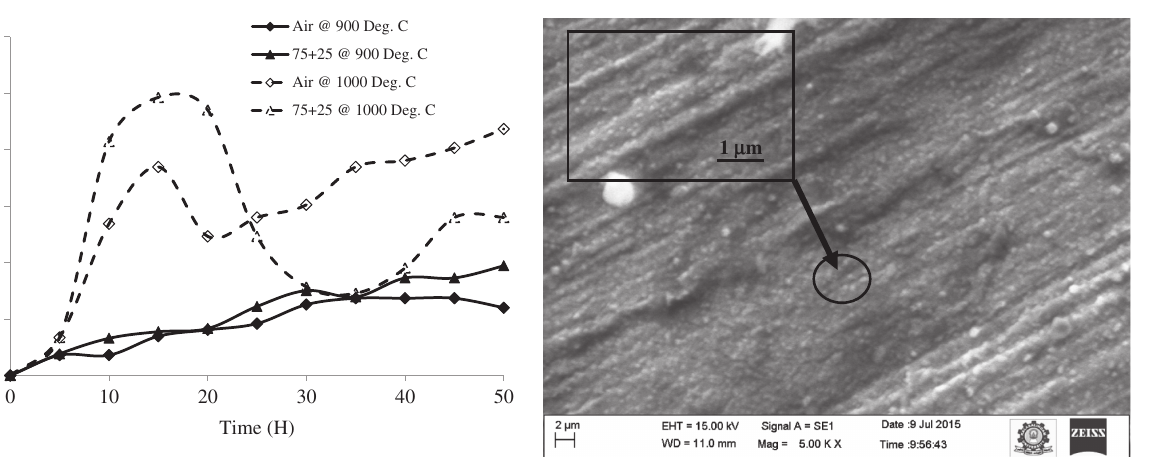
Figure 2: Mass change per unit area with respect to exposed tem- perature and environment. Figure 3: SEM micrograph of Hastealloy X exposed to air at 900°C (Insert: nucleation of oxides observed under higher magnifications).